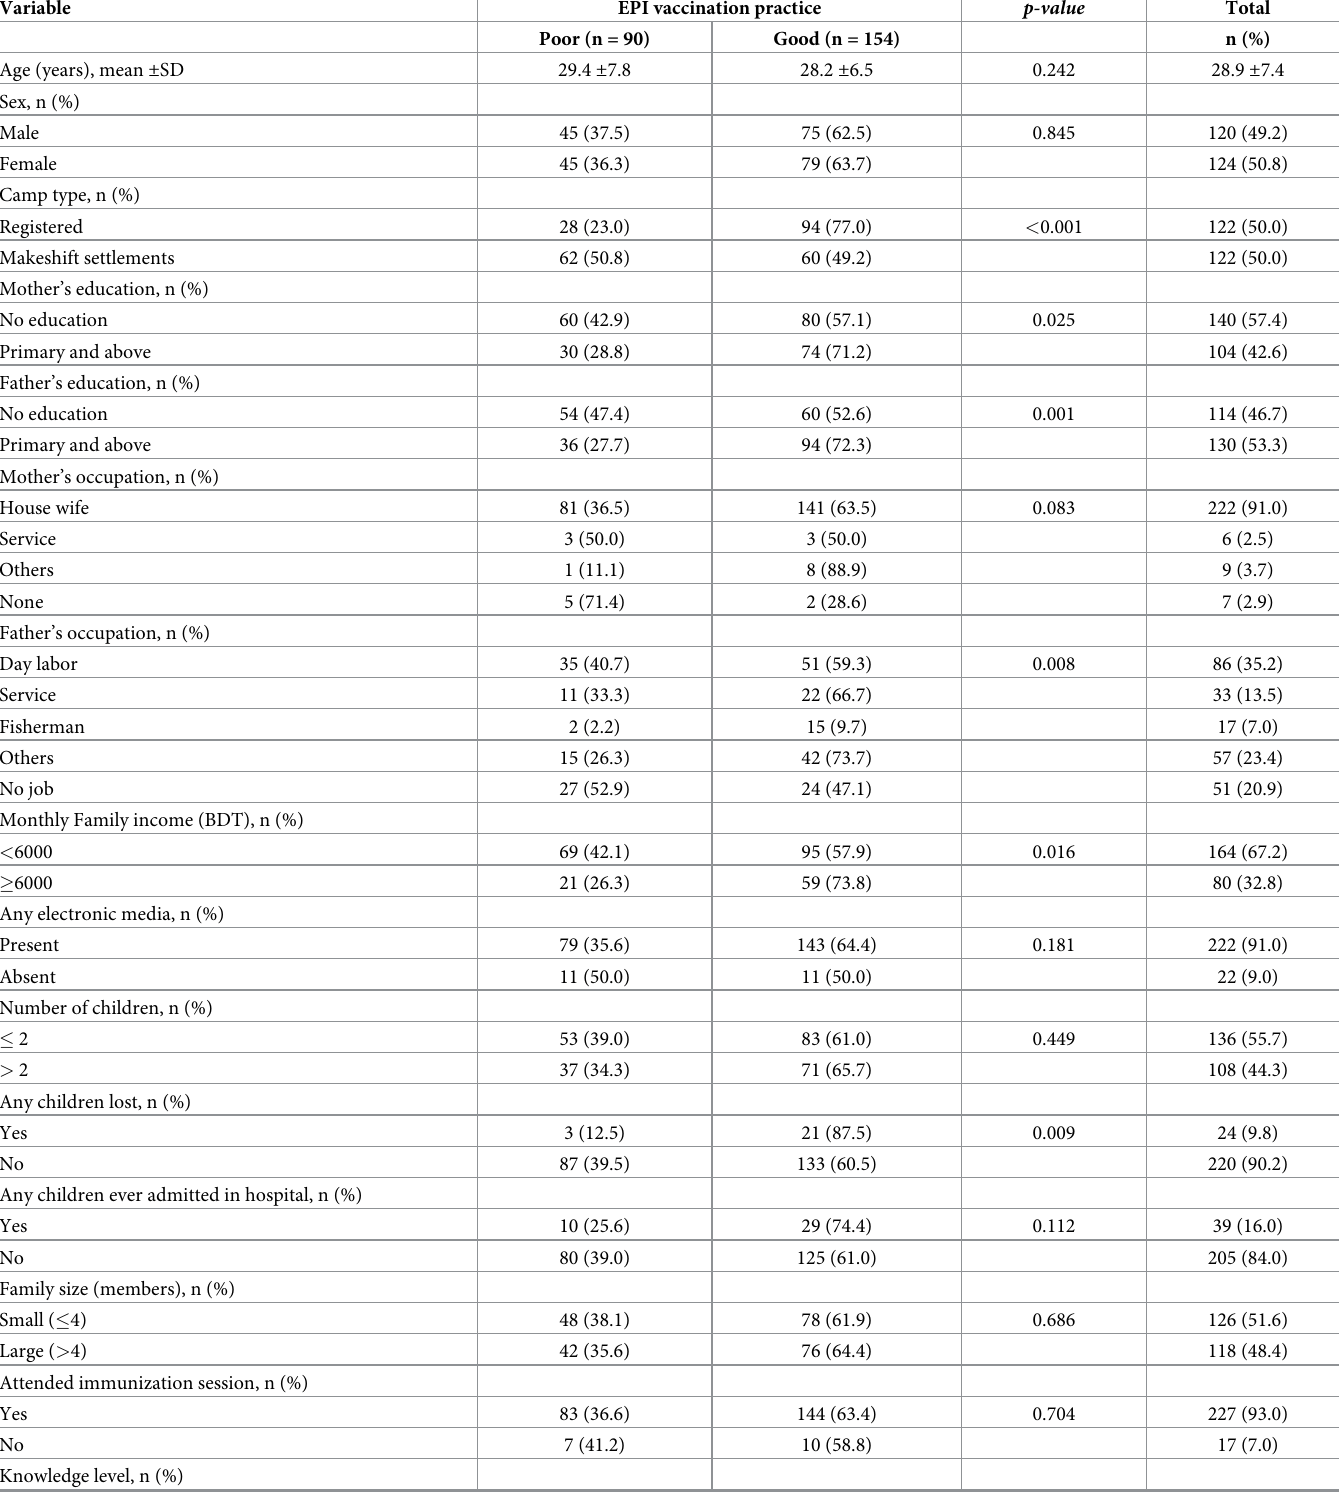
Table 1. Participant characteristics in respect to childhood immunization practice of Rohingya